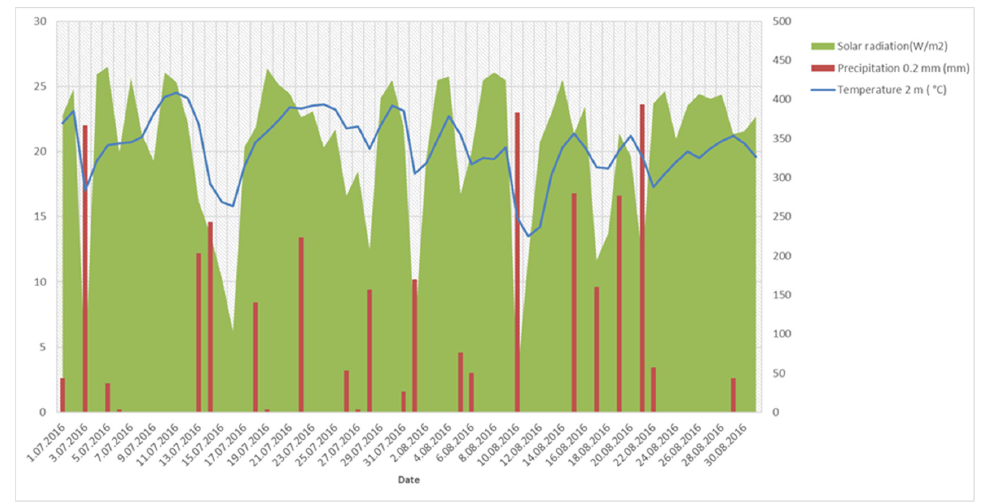
Figure 1. Variation of temperature, precipitation and solar radiation from 1 July to 31 August. Elagitannins (ETs) are compounds in which gallic acid is bound to hexahy- droxydiphenic acid (HHDP). We distinguish among monomeric (derivatives of el- lagic acid), oligomeric (Sanguiin H-6) and polymeric forms of ellagitannins. During their hydrolysis, ellagic acid is released. ETs together with gallotannins belong to the group of hydrolysing tannins [37]. Elagitannins have been found in various berries, e.g., raspberries, strawberries, blueberries and cloudberries [38]. In our experiment, total ellagitannin contents in blackberries ranged from 43.4 to 202.3 mg/kg FW (Table S3). ‘Smoothstem’ and ‘Thornfree’, with an average content of 181.5 and 189.4 mg/kg FW, respectively, stood out for their high content of ellagitannins. Interestingly, ‘Loch Ness’ had up to 3.5 times less total ellagitannins at all sampling times. There were only slight differences in their content between the different weekly sampling dates.